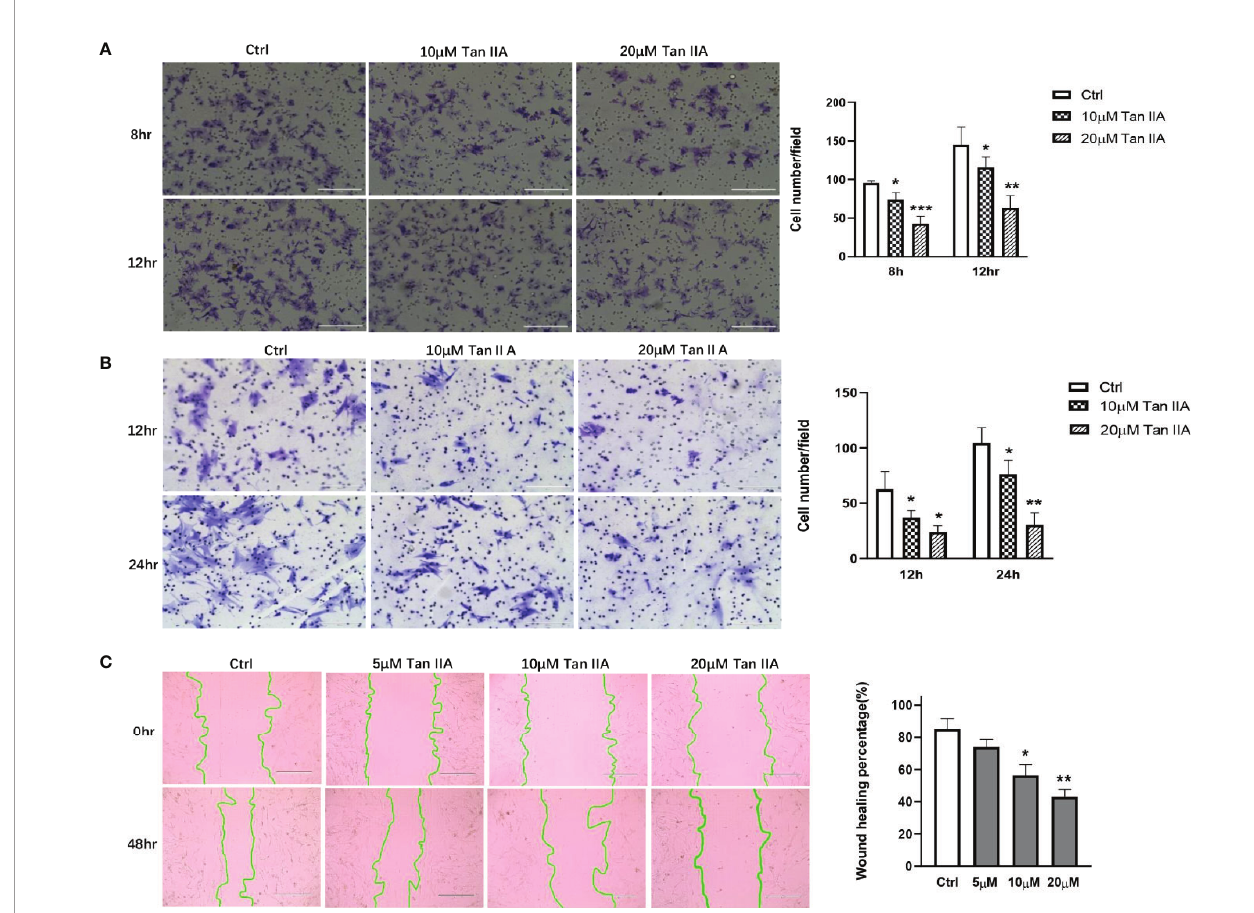
FIGURE 3 | Tan IIA suppresses the migration and invasion of RA-FLSs. (A) The effect of Tan IIA on migration was detected with transwell Boyden chamber after 8 and 12 h. The images are representative of migration or invasion through the membrane after staining. Original magni fi cation 200× (left panel). Cell numbers/ fi eld are presented as the mean ± SD of eight independent fi elds (right panel). (B) The effect of Tan IIA on invasion was detected with a transwell Boyden chamber coated with a Matrigel basement membrane matrix after 12 and 24 h. The images are representative of migration or invasion through the membrane after staining. Original magni fi cation 200× (left panel). Cell numbers/ fi eld are presented as the mean ± SD of eight independent fi elds (right panel). (C) The effect of Tan IIA on wound healing was detected with cell scratch assay. After 48 h, the wound area was photographed using a microscope. Original magni fi cation 100× (left panel). The extent of wound closure is presented as the percentage by which the original scratch width had decreased at each measured time point. The values are the mean ± SEM from at least 3 independent experiments (right panel). * P < 0.05, ** P < 0.01, *** P < 0.001 vs. 0 m M